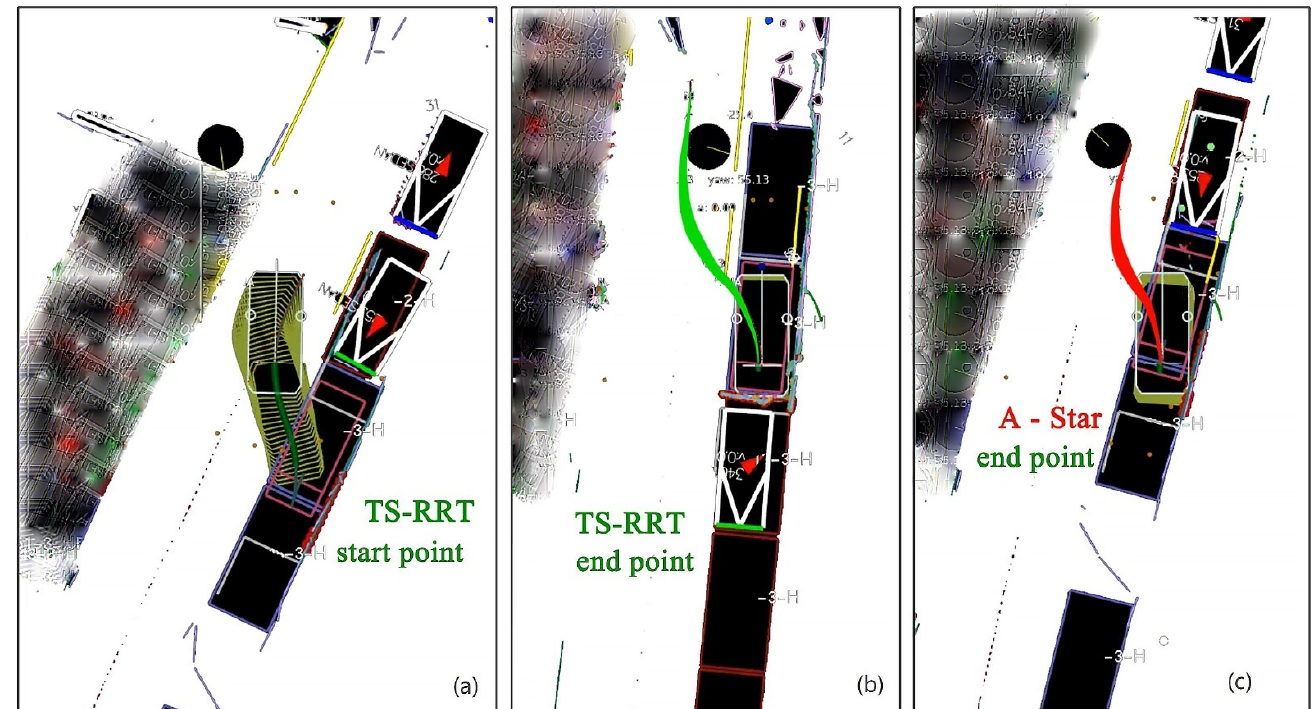
Figure 6. Comparison of algorithm effectiveness in parking planning: ( a ) start status of TS-RRT planning, ( b ) end status of TS-RRT with successful planning, ( c ) end status of A* planning with collision failure.